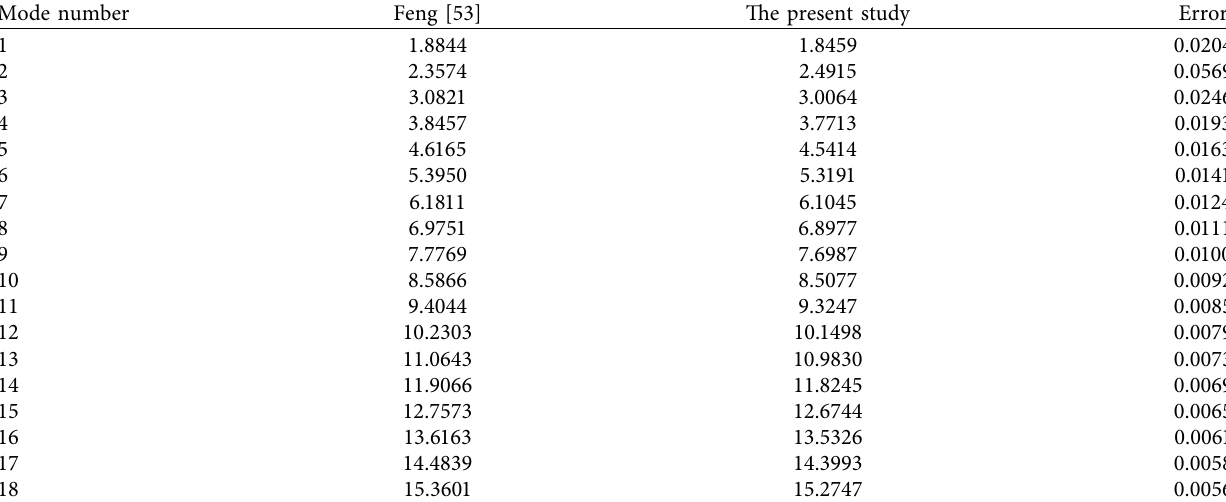
Table 3: Comparison of natural frequency